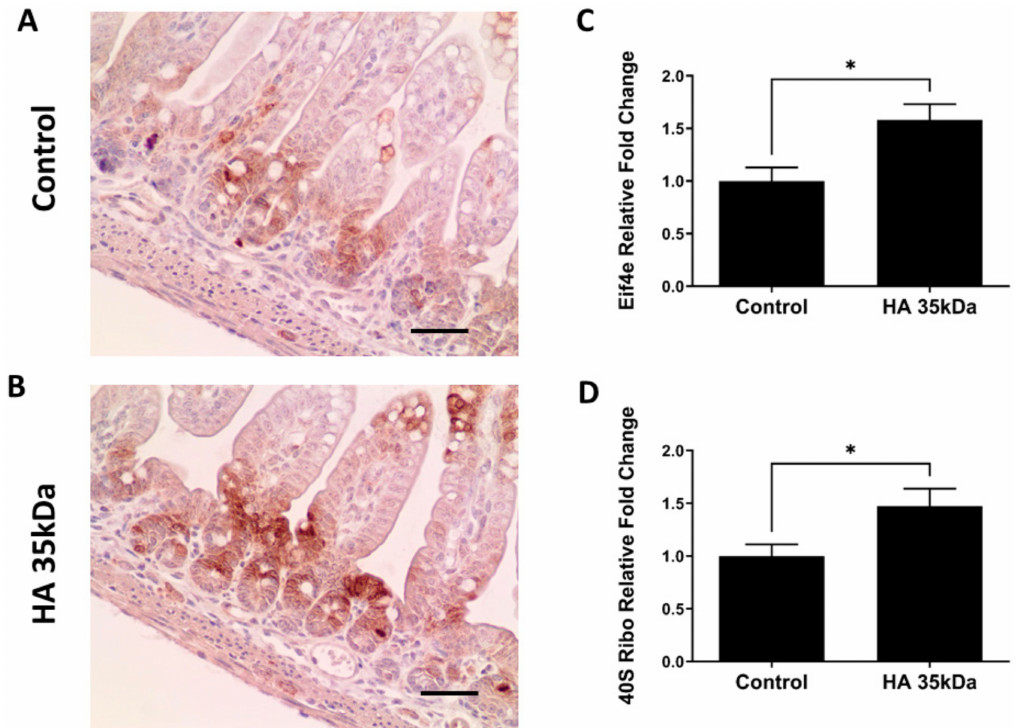
Figure 9. Oral HA 35 KDa activates the mTOR pathway within the intestinal epithelium of P14 pups. Representative immunohistochemical staining for phosphorylation of ribosomal protein S6 in ileal sections from controls ( A ) and HA 35 KDa-treated pups ( B ) Scale bars = 50 µ m. Confirmatory mRNA expression for Eif4e ( C ) and 40S Ribo ( D ) ( n = 21). Data presented as mean ± SEM. HA: hyaluronic acid; Eif4e: eukaryotic translation initiation factor 4e; mTOR: mechanistic target of rapamycin; SEM: standard error of the mean. * p <